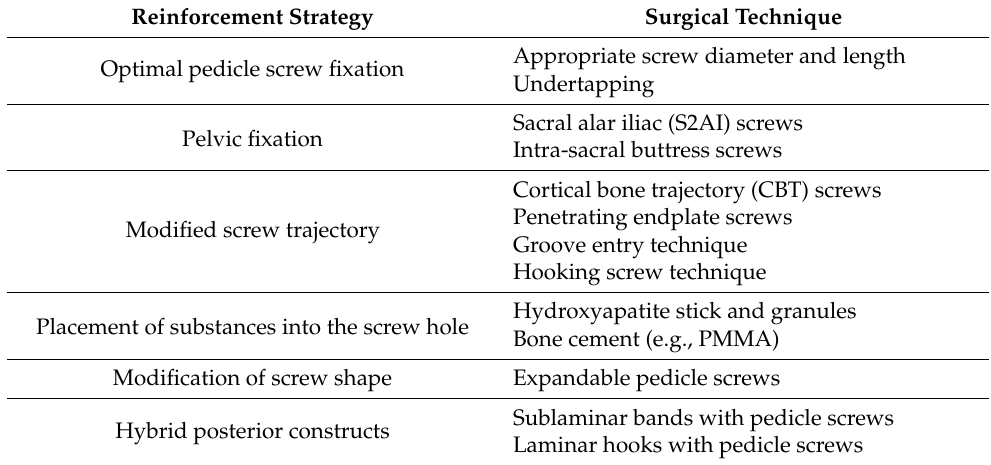
Table 1. Surgical techniques to reinforce screw fixation in patients with osteoporotic